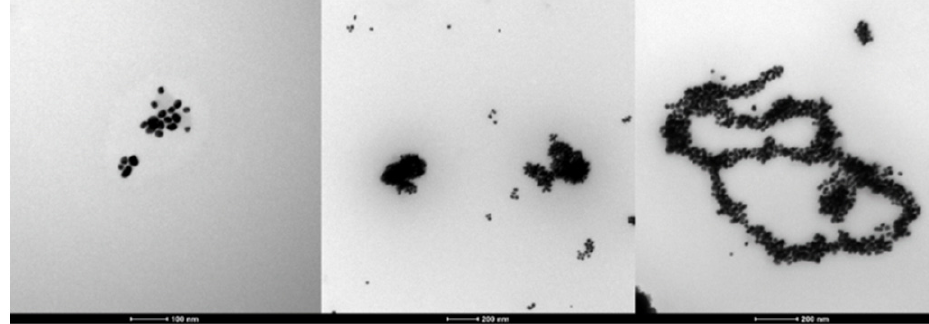
Figure 5. TEM image of Au − CuO hybrid nanofluid.